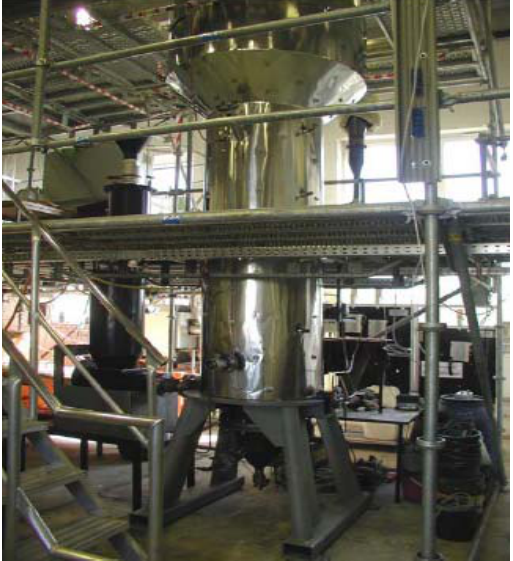
Figure 4. Experimental equipment SFBC at the CET Rostock University, Germany